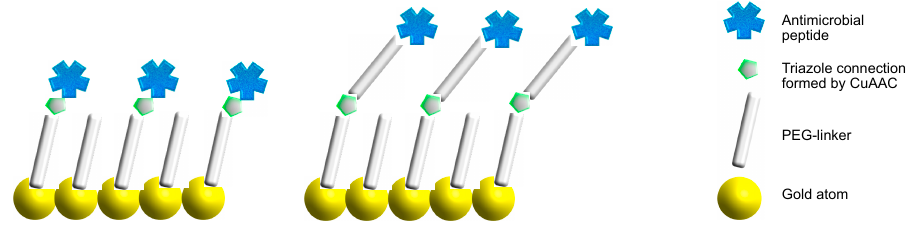
Figure 1. The design of the peptide-functionalized self-assembled monolayer (SAM) gold surface. The peptides were connected by a CuAAC reaction either directly to the terminus of the SAM (peptides 1c , 1d , 2c , and 2d , left), or through an additional PEG linker (peptides 1a , 1b , 2a , and 2b , right).